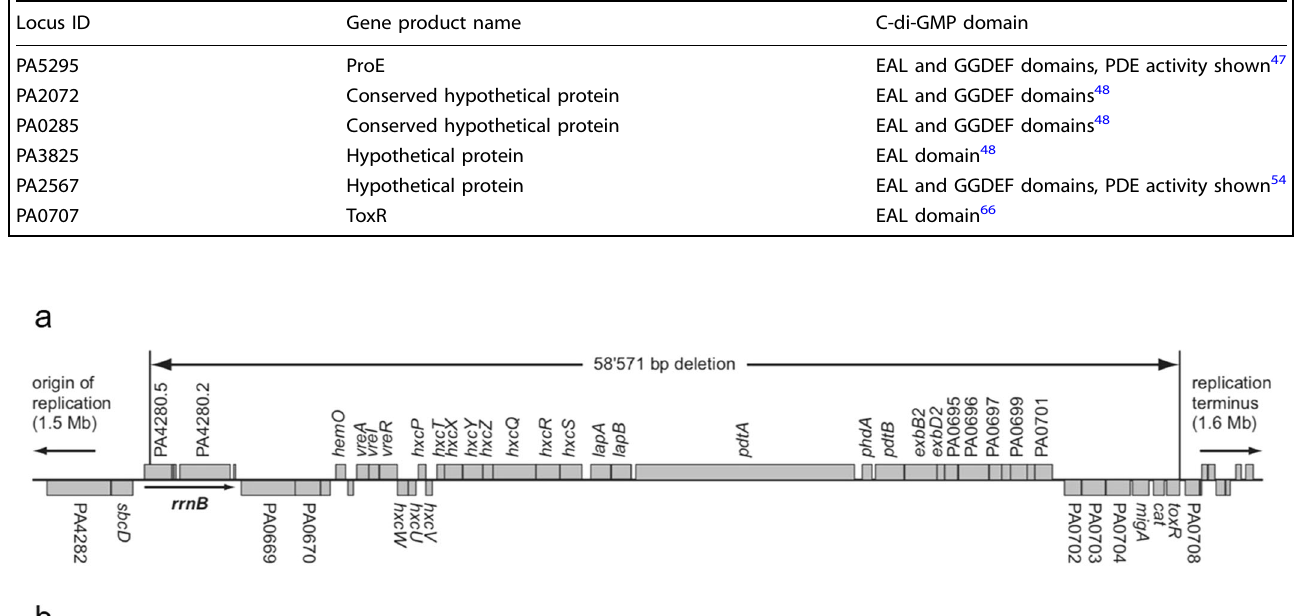
Fig. 3, the triple mutation Δ rsmA Δ toxR bifA Y442D resulted in swarming impairment in PAO1-L. At the same time, the reversion of Y442D to D442Y restored swarming motility in PAO1-N Δ rsmA , suggesting that bifA is the third genetic element involved in this phenotype which potentially explains motility differences between the two PAO1 sublines.